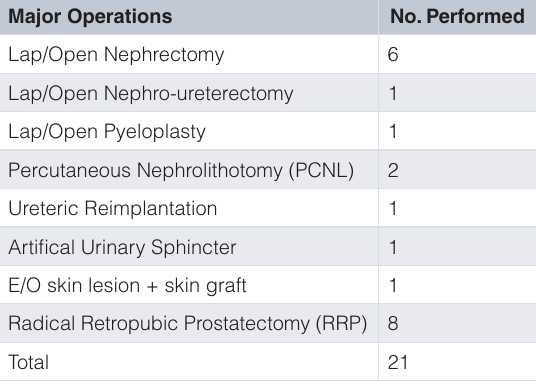
Table 2. Breakdown of the major operative procedure performed during the audit period. Major Operations